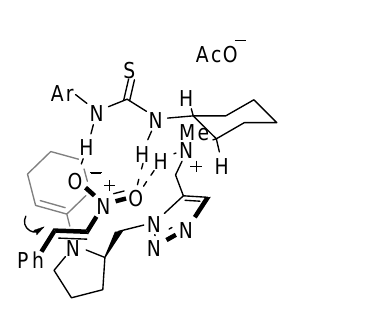
Figure 4. A Proposed Transition State for Michael Addition by Trifunctional Thiourea